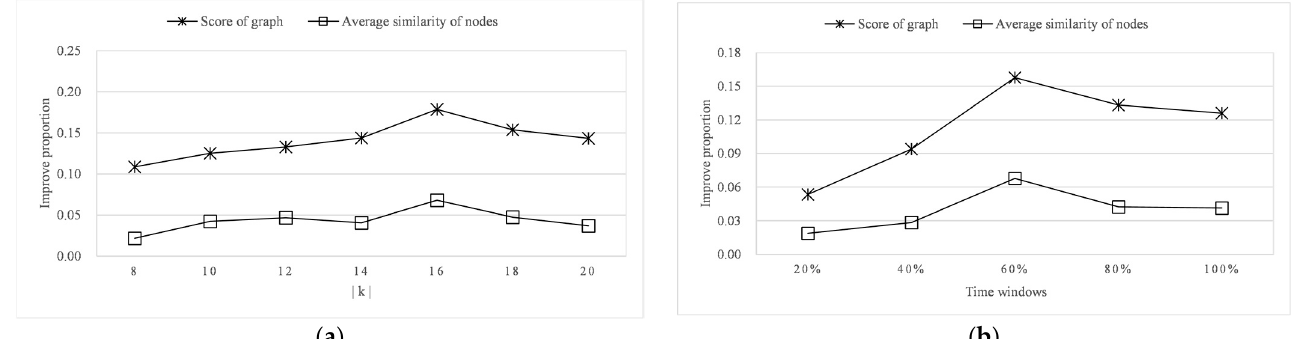
Figure 5. Effectiveness evaluation of different models. ( a ) Change of similarity improve ratio with different k ; ( b ) change of similarity improve ratio with different time windows.